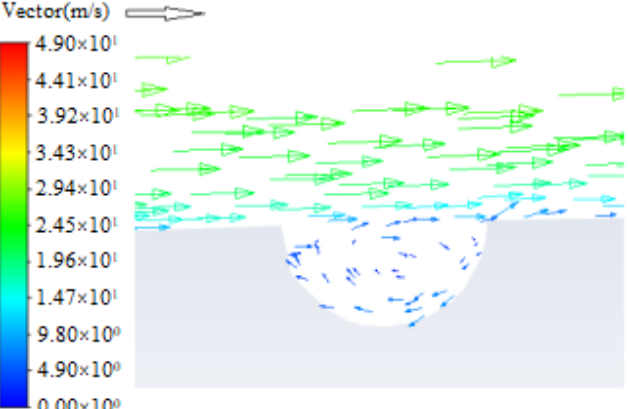
Figure 10. Velocity vector inside the circular concave .